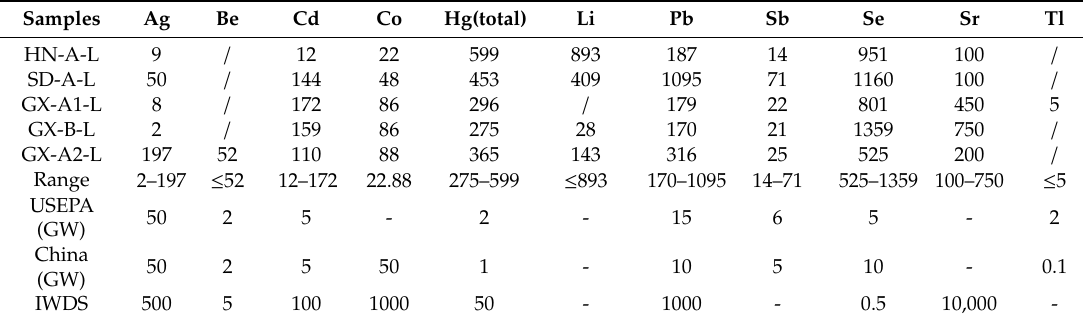
Table 8. The concentration of trace elements in red mud leachate (unit: µ g /